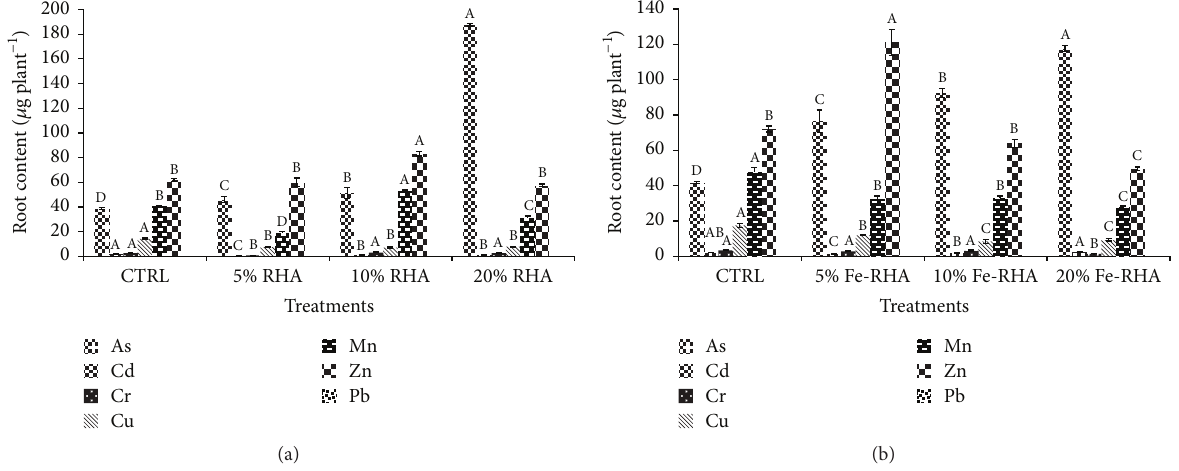
Figure 7: The uptake of As, Cd, Cr, Cu, Mn, Zn, and Pb ( 𝜇 g plant −1 ) in root of vetiver grass grown in gold mine amended with Fe-RHA and RHA (mean 𝑛 = 3 , ± SD). Different letters correspond to significant differences between rates of the same ash ( 𝑃 < 0.05 ). Pb was not detected.